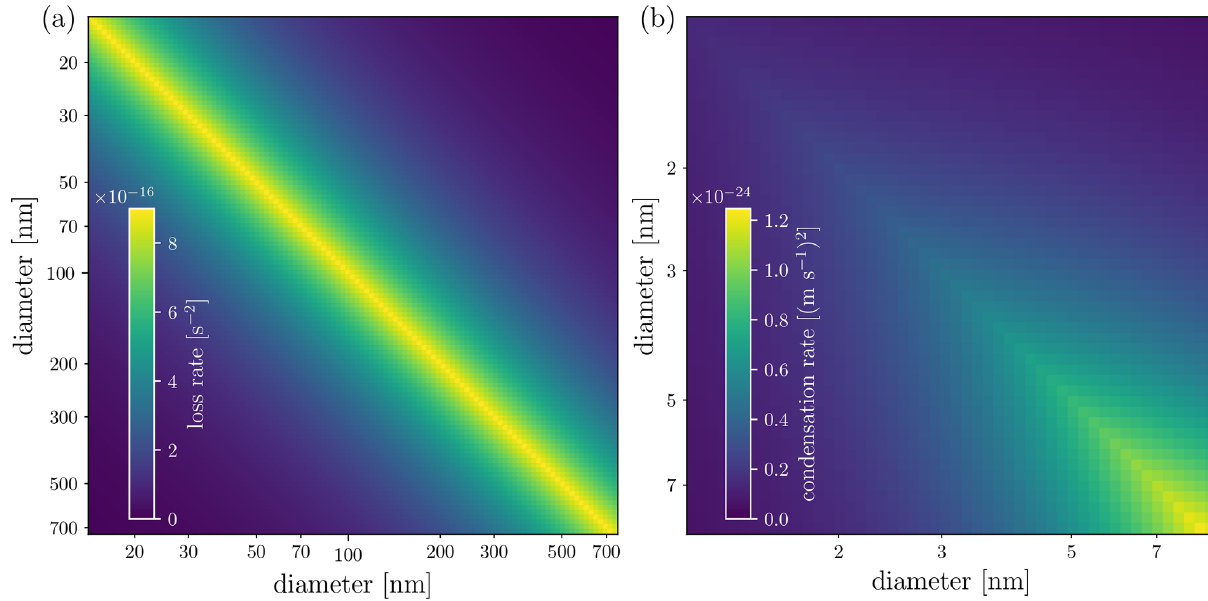
Figure B1. Covariance matrices of (a) the deposition rate λ in cases 1 and 2 and (b) growth rate g in cases 3 and 4.